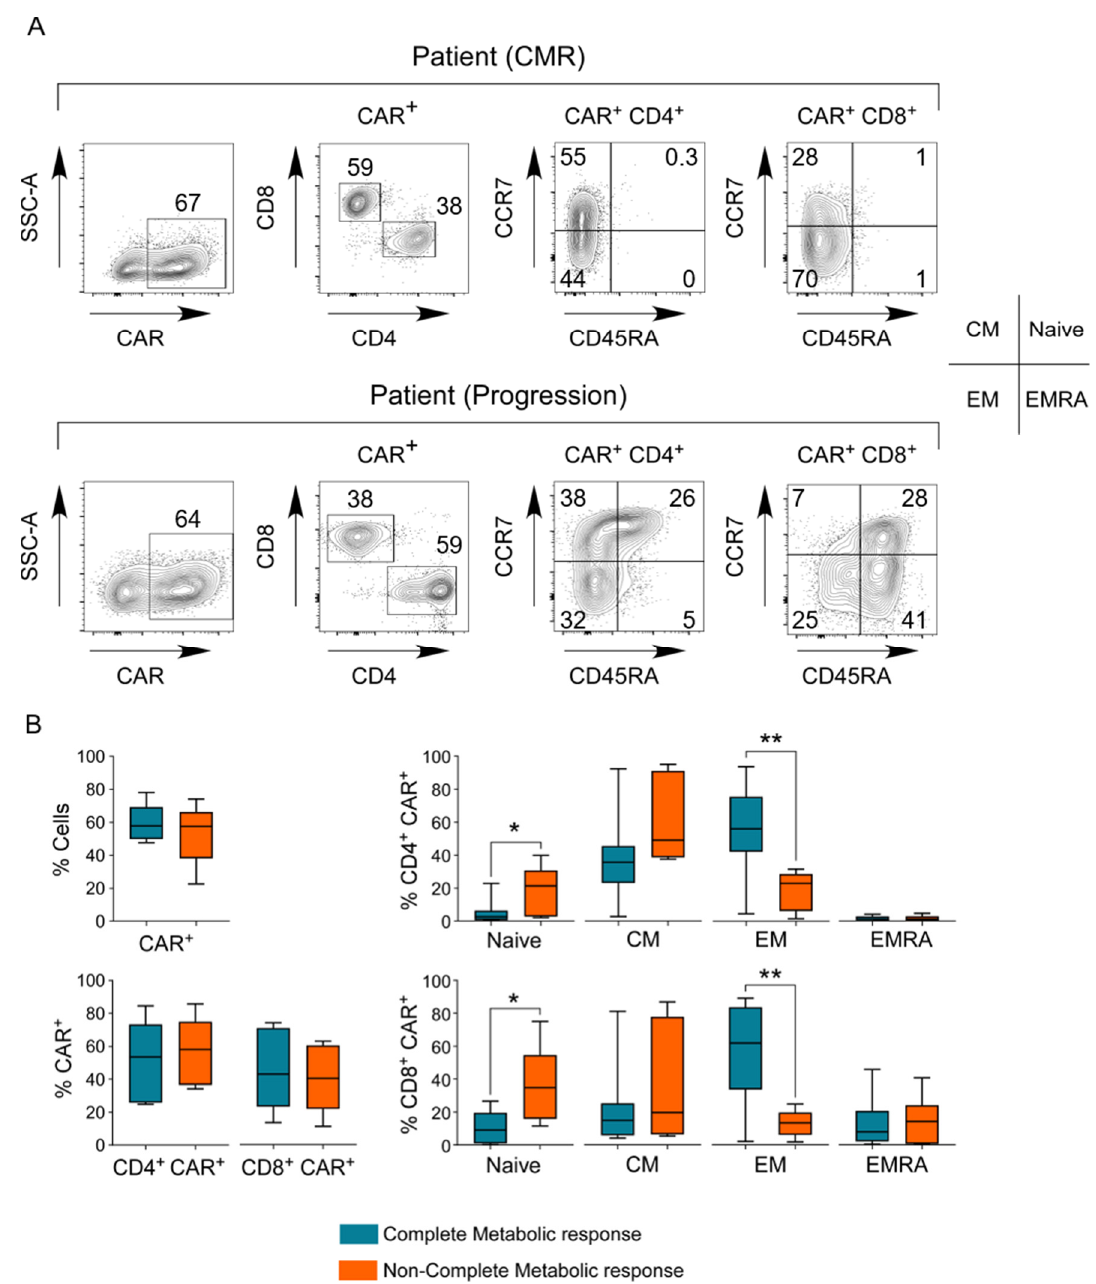
Figure 3. Phenotypes of the CAR T-cell products and correlation with the clinical response. ( A ) Representative dot plots of the CAR T-cell products from one patient with a CMR (above) and one patient with progressive disease (below) are shown. ( B ) Quantification of the percentages of CAR + T-cells in patients who achieved a CMR and patients who did not (top left). Percentages of CD4 + CAR + and CD8 + CAR + T-cells in the two groups are presented (bottom left). The percentages of naive, central memory (CM), effector memory (EM), effector memory re-expressing CD45RA (EMRA), and CD4 + CAR + and CD8 + CAR + T-cell subsets were determined, and the median, IQR, and range (n:16) are presented. p -values were calculated using a Mann Whitney test and significant values are shown (*, p -value between 0.02 and 0.05; **, p <